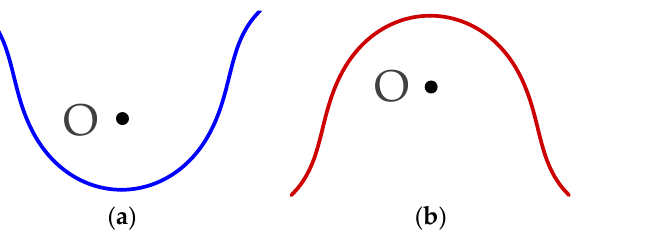
( b ) Figure 5. The drop ( a ) at gauge pressure of H 1 min , and bubble ( b ) at gauge pressure of H 2 max with the drawn cross sections of the spheres that result from Equation (33); the hydrostatic pressure in Equa-